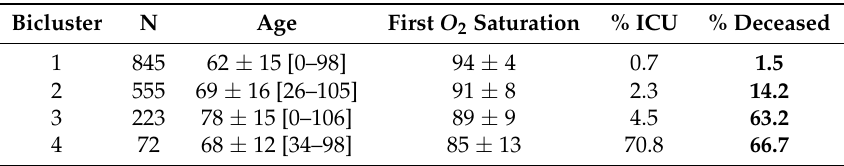
Table 7. Patient statistics in each